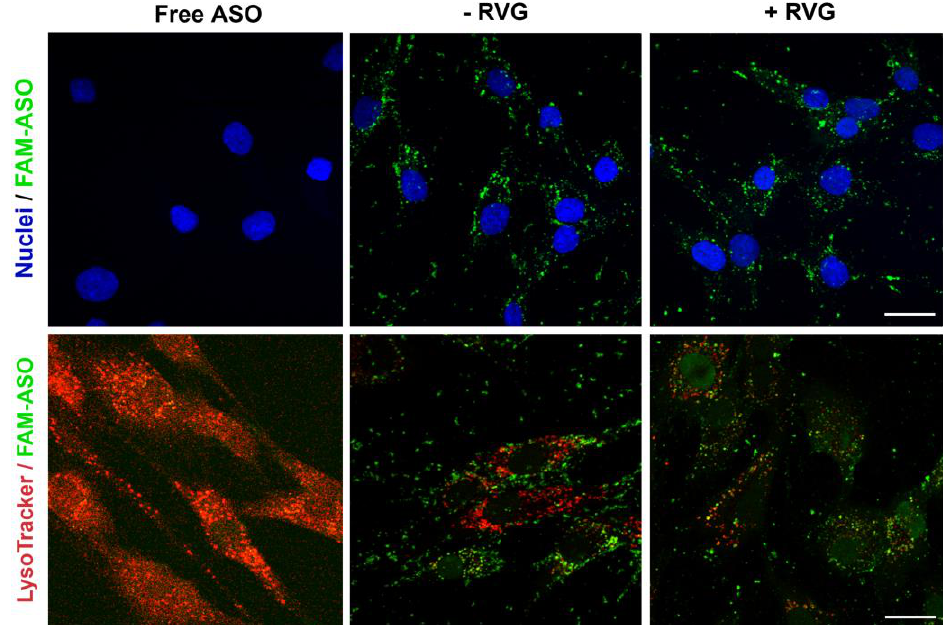
Figure 9. Cellular uptake and late endosome/lysosome escape of RVG-targeted cyclodextrins (CDs):ASO nanocomplexes. Representative confocal fluorescence images of fibroblasts from an HD patient (CAG15/67) treated with ASO alone or complexed with CDs (100 nM final concentration) for 6 h. Intracellular fluorescence of FAM-labelled ASO (green), nuclei (blue), and LysoTracker Red DND-99 (red). The yellow color indicates co-localization. Scale bar: 25 μm.